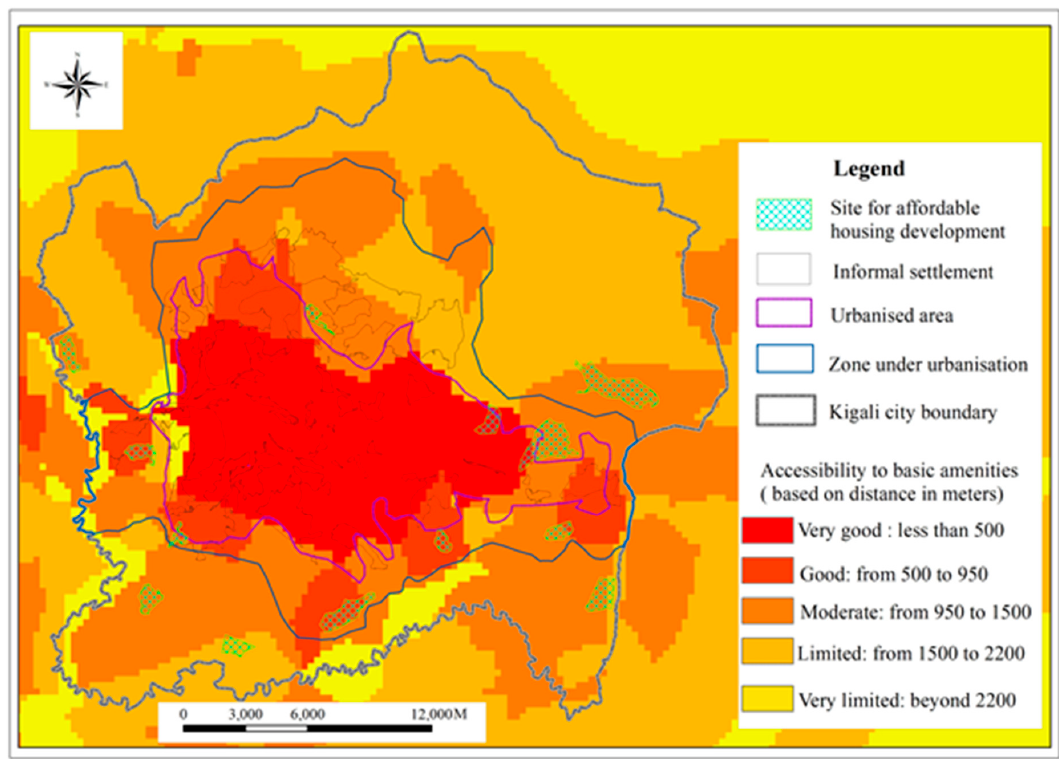
Figure 5. Spatial distribution of the affordable housing projects and informal settlements in Kigali city. Data source: field survey (July to September 2018).